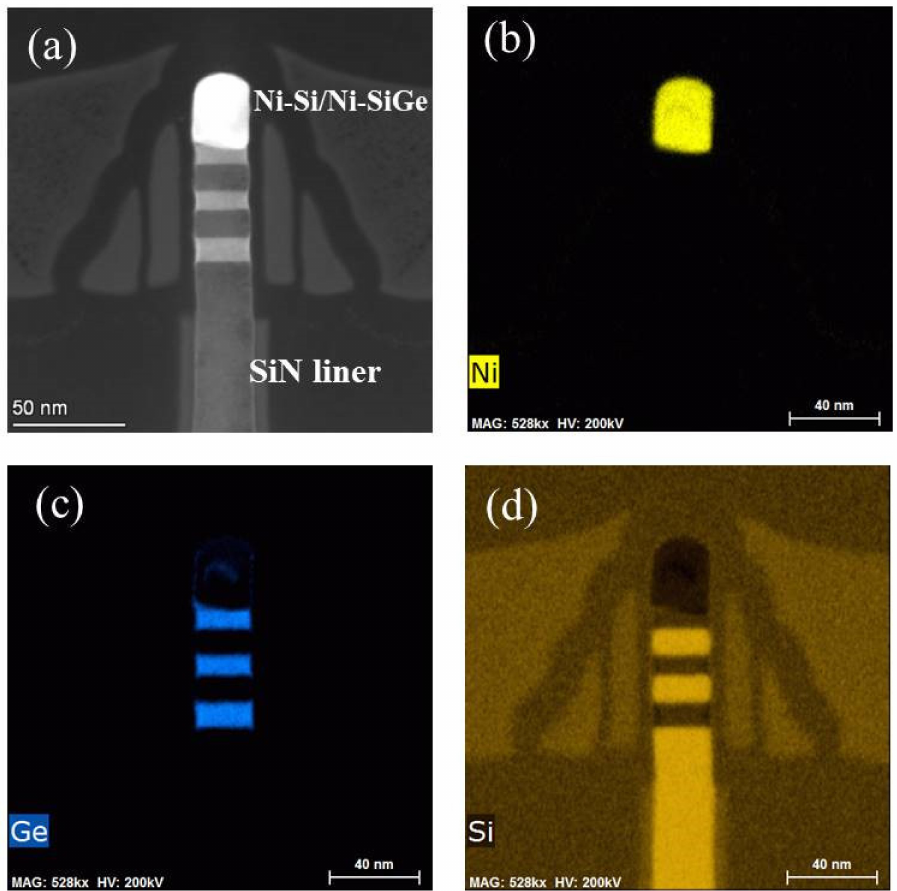
Figure 8. ( a ) The cross–sectional images of S/D region of 4-levels vertically stacked Si 0.7 Ge 0.3 NWs GAA device at perpendicular to fin direction and its EDX mapping of Ni ( b ), Ge ( c ), and Si element ( d ) distribution. The I DS -V GS , g m -V GS and I DS -V DS characteristics of 4-levels vertically stacked Si 0.7 Ge 0.3 NWs GAA device with S/D silicide process are shown in Figure 9a–c, respectively. Compared with device without S/D silicide process, the I on can increase from 38.6 to ~258.6 µ A/ µ m (about 6.7 times), as well as the g m,max can increase from 83.35 to 562.73 µ S/ µ m (about 6.7 times), because its R SD can reduce from 9.2 × 10 5 to 6.4 × 10 4 Ω by employing the S/D silicide process. These results verified that the S/D silicide process can improve the I on of the 4-levels vertically stacked Si 0.7 Ge 0.3 NW GAA device by reducing its R SD